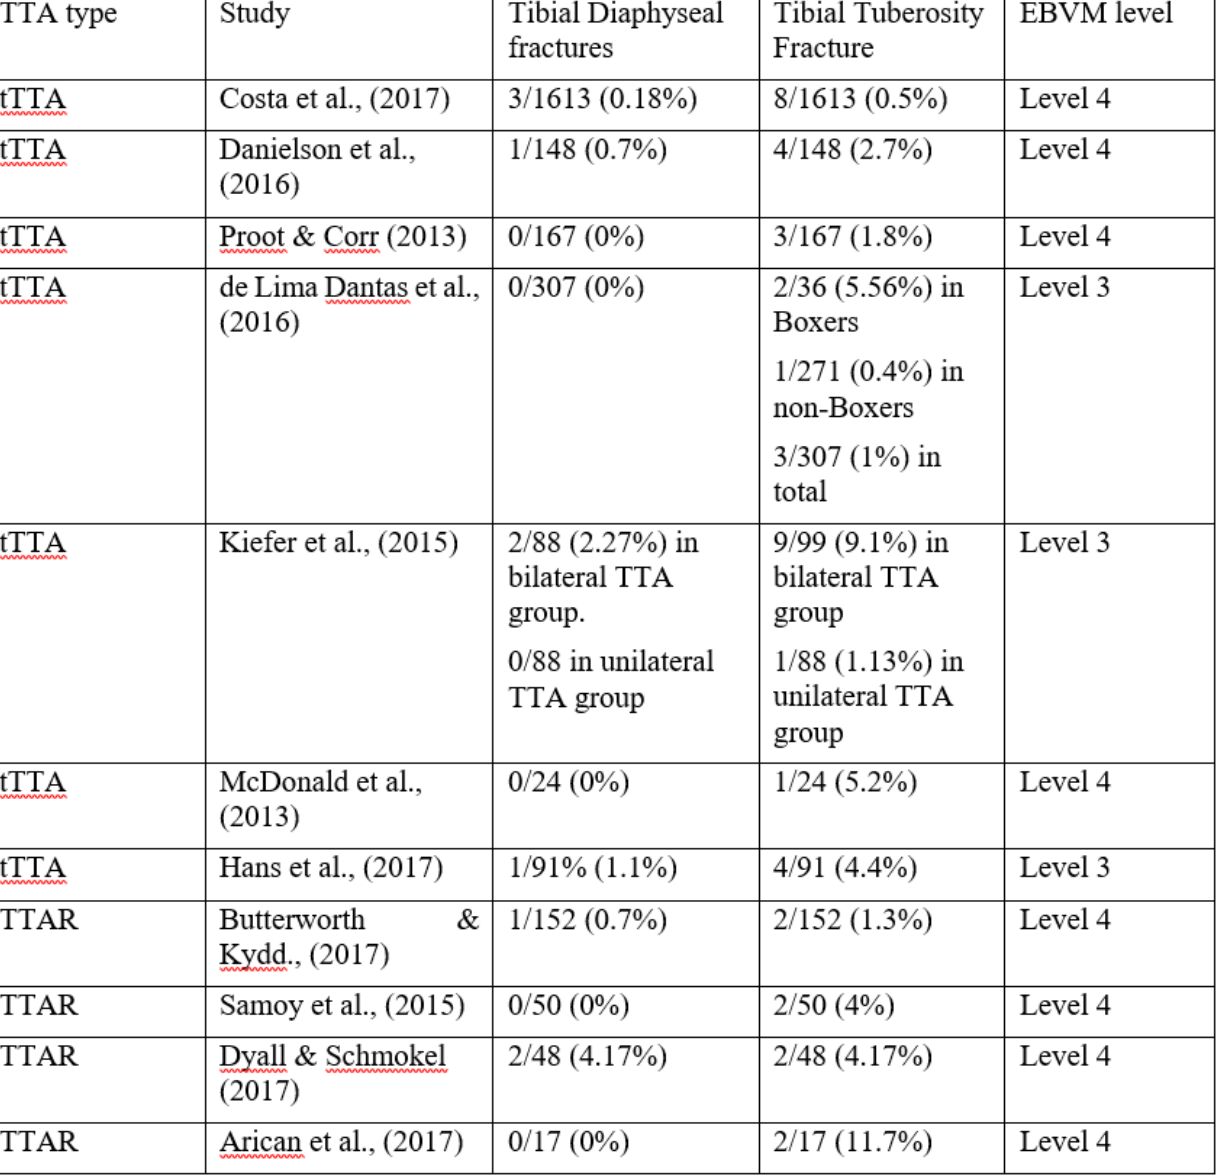
Table 2: Based on recent (< 5 years) studies relevant to the PICO, tibial diaphyseal fractures are reported in the table. While not directly related to the PICO, tibial tuberosity fractures are also included. From this table, the rate of tibial diaphyseal fractures from tTTA (0–2.3%) compared to TTAR (0–4.17%) are roughly comparable. In the TTAR group, Dyall & Schmokel’s (2017) report of 4.17% tibial diaphyseal fractures using TTAR on small breed dogs (< 15 kg) was notably higher than the other three studies. The higher fracture rate was attributed to the relatively large cage size, which may have overwhelmed the elasticity of the cranial tibial cortex, predisposing to fracture. If small breed dogs were excluded from the comparison then the rate of tibial diaphyseal fractures for TTAR would be 0–0.7%, which is within the published limits for tTTA (0– 2.3%). A two-tailed T test (https://www.socscistatistics.com/tests/studentttest/Default2.aspx) comparing TTAR (0, 0, 0.7, 4.17) vs tTTA (0.18, 0.7, 0, 0, 2.27, 0, 1.1) reveals t -value of 0.7246 and p -value of